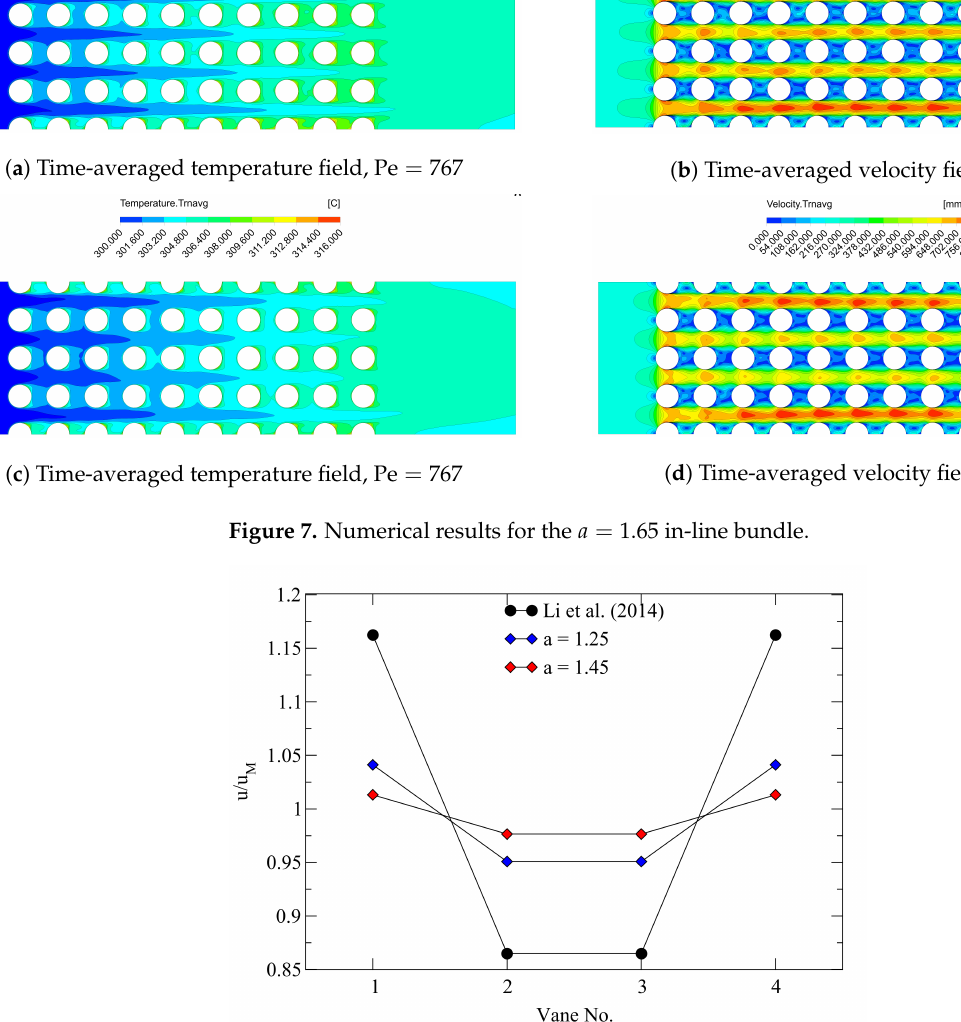
Figure 8. Time- and spatial-averaged velocity in the in-line bundle vanes sampled at the center of rod column No. 5 (cfr. Figure 2 for numbering) at Pe = 767 (Re = 3.47 × 10 4 ). Results are compared with data taken from Ref. [29], where Re = 3.8 × 10 4 , a = 1.38 and b = 1.15. Vane No. 2 and 3 in the figure corresponds to vane no. 3 and 4 in Ref.